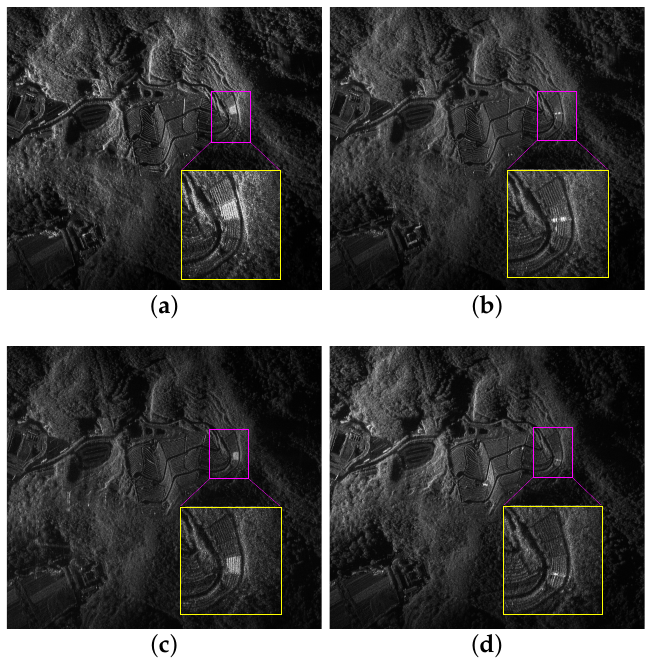
Figure 19. ViSAR image of mountain scene. ( a ) Frame 49, ( b ) Frame 148, ( c ) Frame 236 and ( d ) Frame